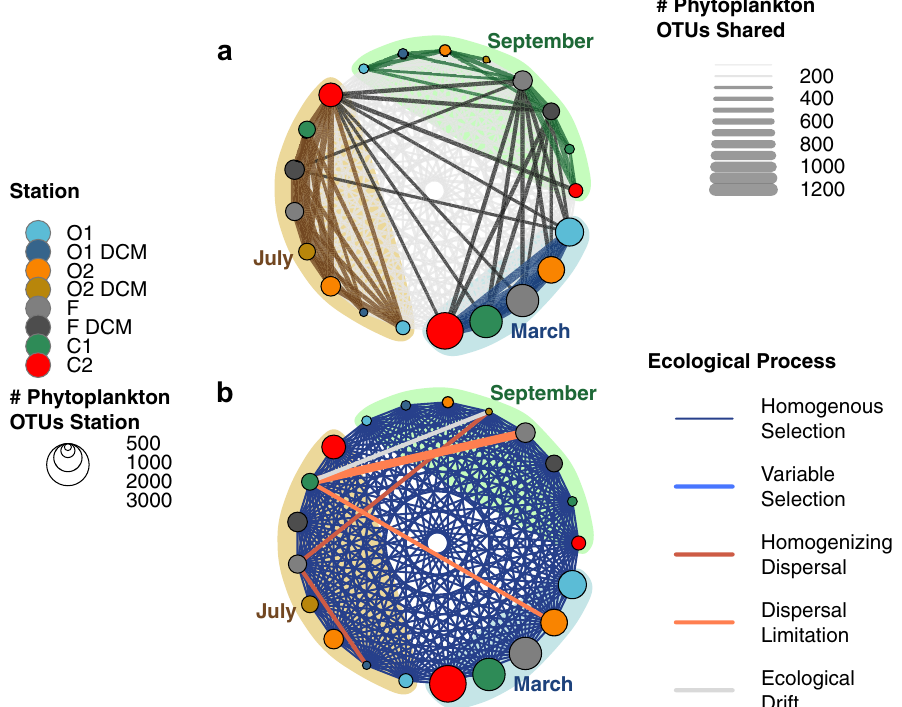
Figure 4. Spatiotemporal patterns of diversity and the dominant ecological processes driving eukaryotic phytoplankton communities sampled in the Iroise Sea in March, July and September 2015 across our 5 stations and depth (at surface and DCM). ( a ) OTU-connectivity network, the node size represents the number of OTUs in each station (see node color) and each season; the edge width represents the number of OTUs shared between stations; the edge color represents: low connectivity (light grey in the background, < 300 OTUs shared), intra- seasonal connectivity (colored) and cross-seasonal connectivity (black). ( b ) Dominant ecological processes explaining the pairwise differences between phytoplankton communities sampled in the Iroise Sea, the edge color represent the dominant ecological processes between the communities of each station as estimated in the approach of reference 55 . On the figure, we put emphasis on processes different from Homogenous Selection, the process dominating 5541 out of the 5551 pairwise community comparisons in our dataset. The edge width linking ‘C1 in July’ and ‘F in September’ was doubled because an ecological process other than Homogenous Selection appeared more than once (across replicates of the micro-plankton). All networks were plotted using the R package “igraph” 54 .